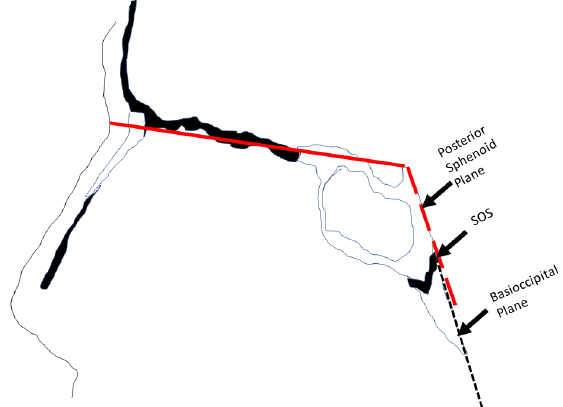
Figure 1. Schematic visualization of angular measurements. Cranial base angle (CBA) was identified in all subjects as occurring between Nasion , top of Dorsum sellae and posterior Sphenoid plane . Posterior Sphenoid plane was defined as the line between both blue circles, at the junctions of Dorsum sellae and Sphenoid bone and Sphenooccipital synchondrosis (SOS). SOSA: Spheno-occipital synchondrosis